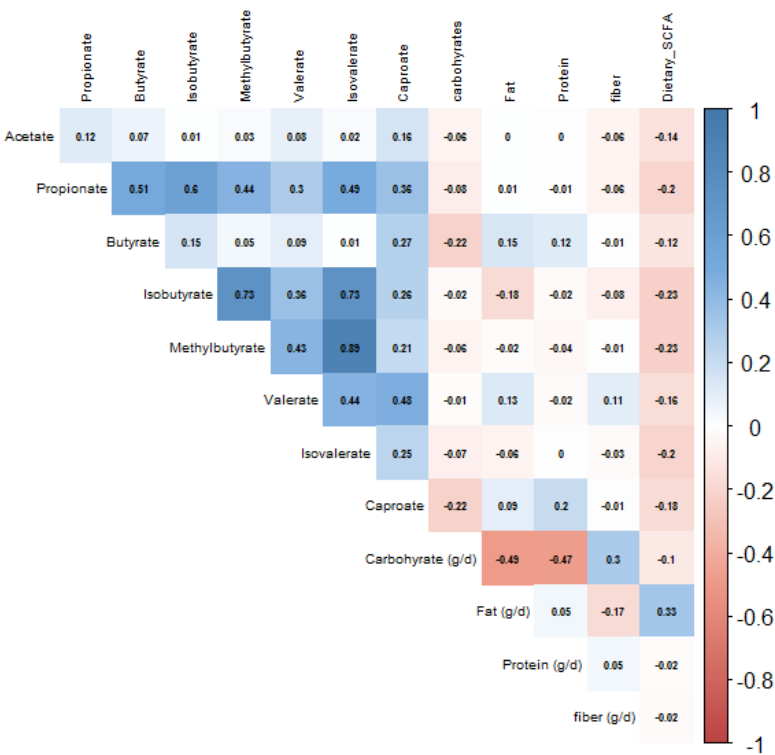
Figure 1. Spearman’s correlation of acetate, propionate, and butyrate with carbohydrate, fat, protein and dietary SCFA intake, n = 144.